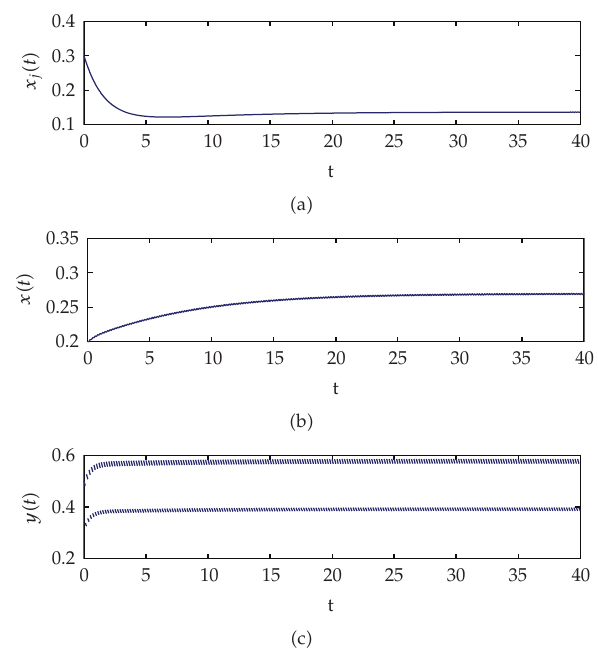
Figure 1: Time series of system (cid:3) 2.4 (cid:4) with parameters d (cid:8) 0 . 6; d 1 (cid:8) 0 . 4; α (cid:8) 0 . 8; τ (cid:8) 0 . 8; d 2 (cid:8) 0 . 5; β (cid:8) 0 . 8; λ (cid:8) 0 . 9; p (cid:8) 0 . 3; μ (cid:8) 0 . 2; T (cid:8) 0 . 2.